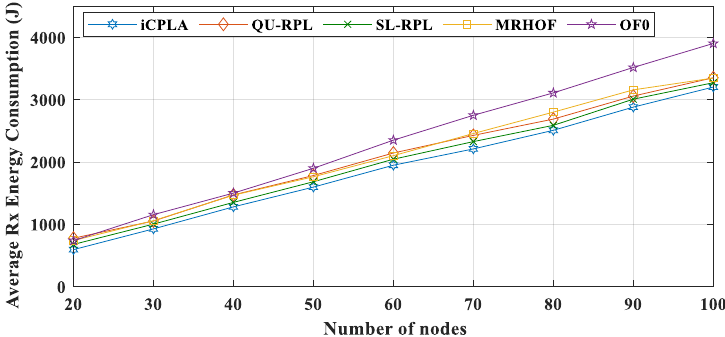
Figure 15. Comparison of average Rx energy consumption (J) between i CPLA, QU-RPL, SL-RPL, MRHOF, and OF0 with 𝛼 = 0.3 and 𝛽 = 0.7 in a network of 20 to 100 nodes.